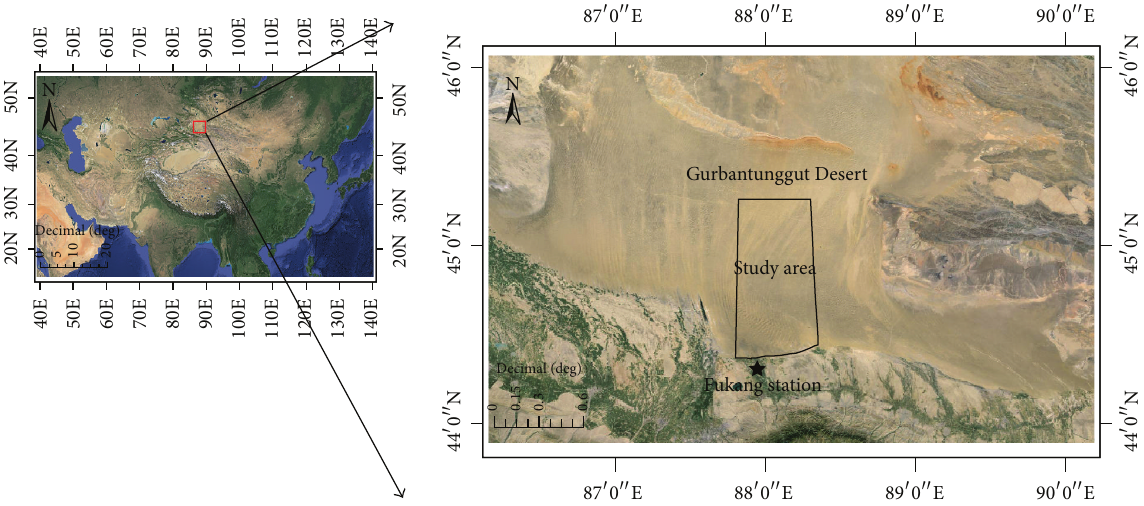
Figure 1: Description of the location of the automatic weather station and study area from Google